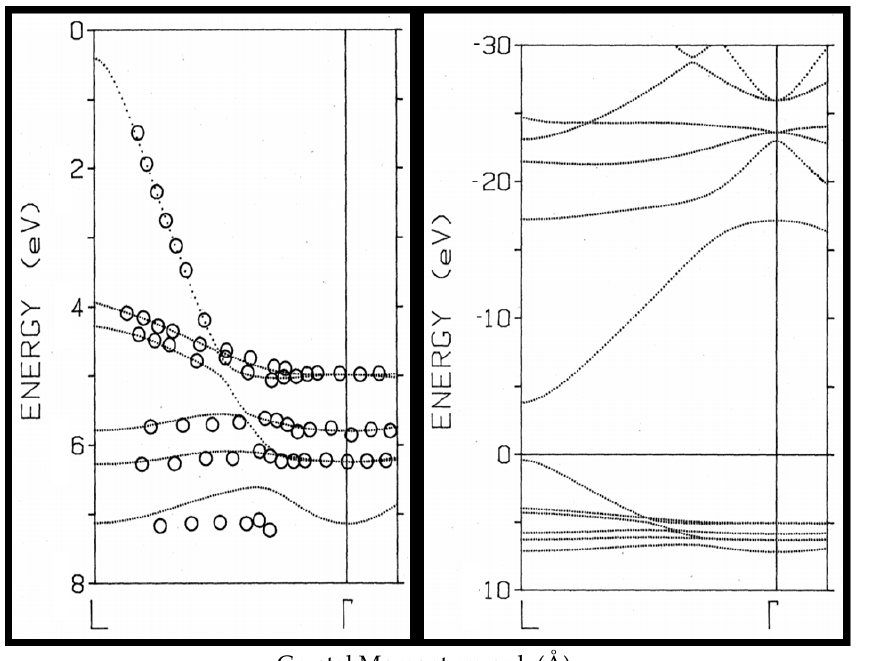
Figure 4. The ARPES band-mapping of Ag(111) and the results of an interpolation scheme [20]. Left panel: Plot of valence-band binding energy with respect to Fermi energy vs. final-state wave vector for the normal emission results (open circles) and the interpolation scheme calculation (dotted lines). Right panel: Interpolation scheme calculation results showing conduction bands to 30 eV above the Fermi level [20].